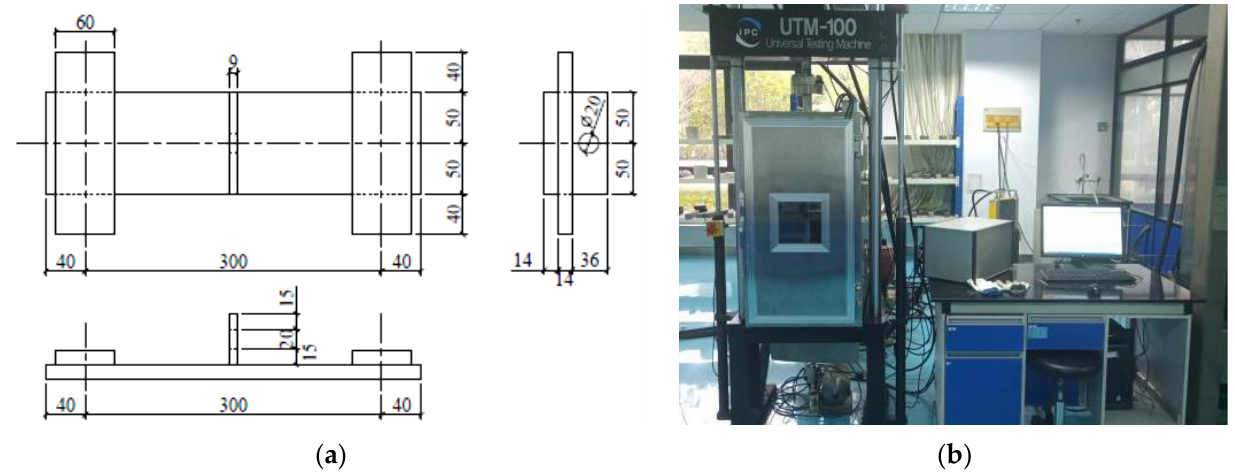
Figure 1. Three-point loading fatigue test device. ( a ) Schematic diagram of three-point loading test; ( b ) UTM-100 fatigue testing machine. Table 6. Specific operation of fatigue test.